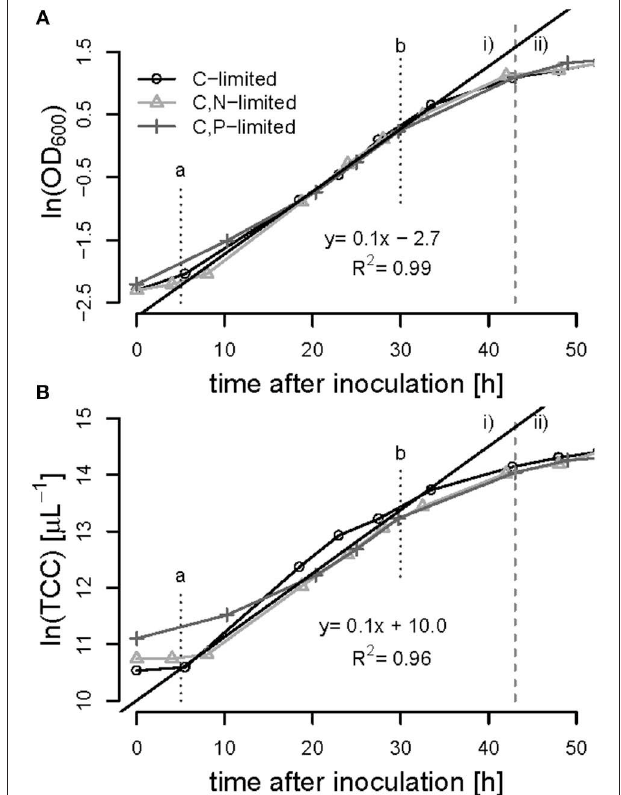
FIGURE 6 | Batch-phase of R. rubrum on syngas and acetate in the bioreactor. The optical density [ln(OD 600 )] (A) and the total cell count [ln(TCC)] (B) was plotted against time. The gray dashed line separates the batch phase (i) from the first continuous acetate feeding phase (ii). The linear trend-line indicates the exponential growth of µ max = 0.1 h − 1 between time points a and b at 5 and 30h of cultivation, respectively. The symbols refer to the nutrient limited phase that will follow later